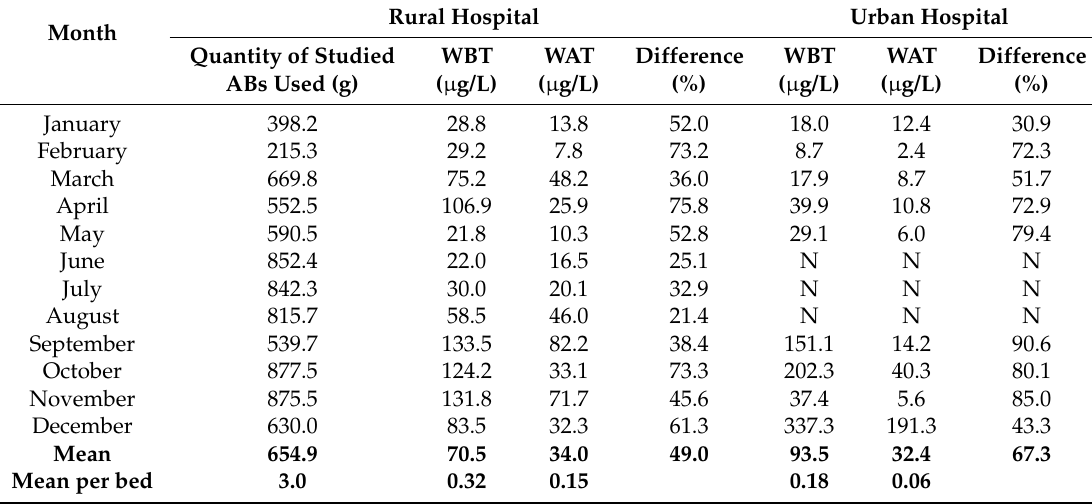
Table 1. Total concentrations ( µ g/L) of studied antibiotics in wastewater of a rural and an urban hospital and the total quantities of studied antibiotics used in the rural hospital in